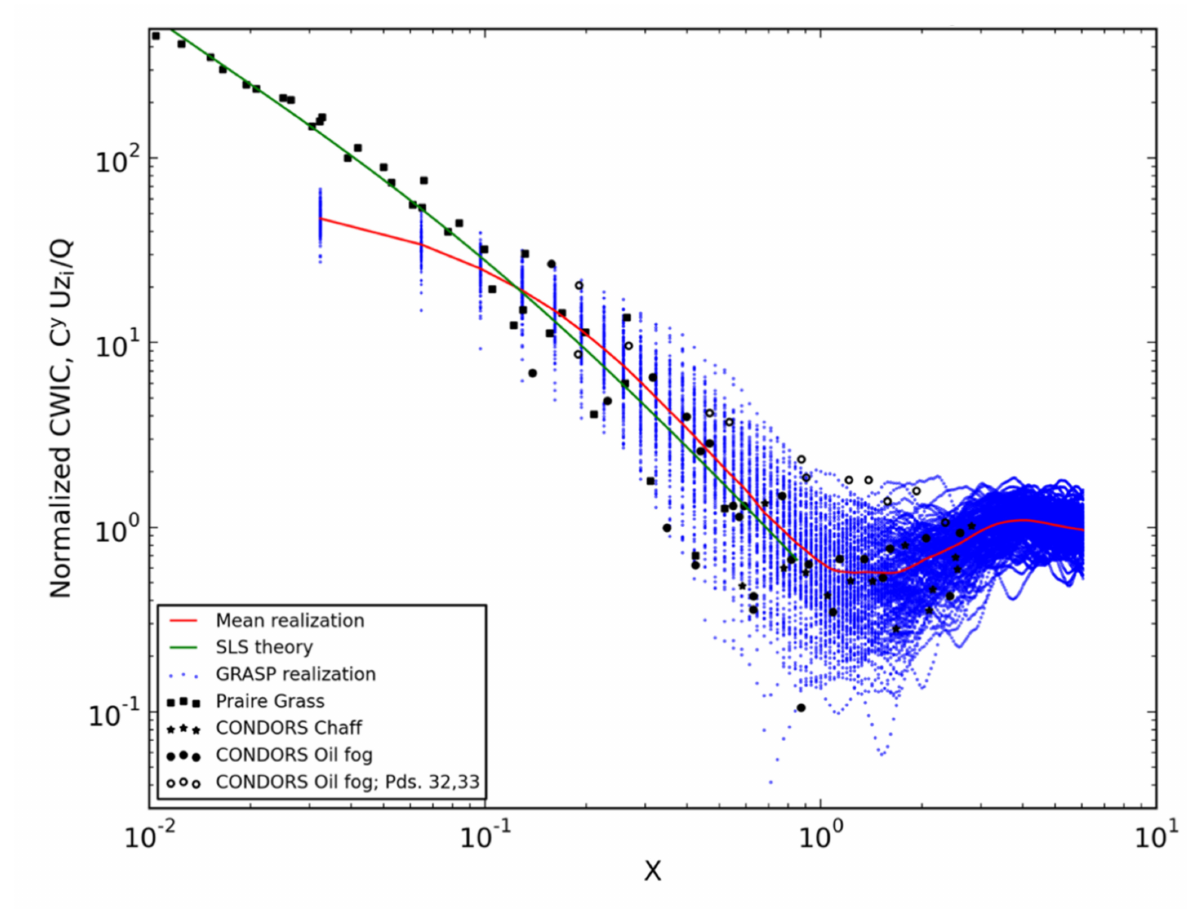
Figure 6. Crosswind integrated concentration as a function of the downwind distance from the release location. The green line represents the dispersion based on surface layer similarity (SLS) theory. The blue dots depict 130 individual realizations from the LES model, and the red line represents the average of these realizations. The markers (closed circles, open circles, squares, and stars) represent observations measured during convective trials in the Prairie Grass and CONDORS